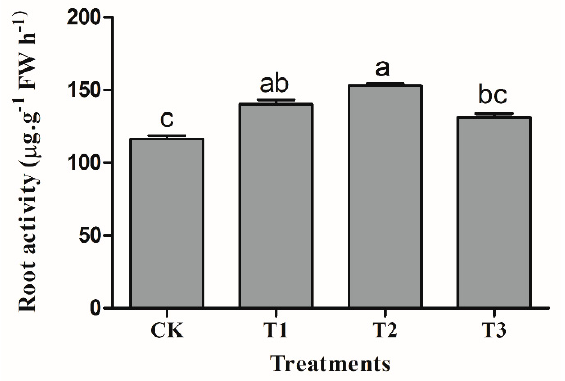
Figure 2. Effect of exogenous ALA application on root activity under low-temperature and weak-light stress. Data are the means of four replicates; error bars indicate the standard deviation. Treatments with the same lower-case letter are not significantly different (least significant difference test, p = 0.05).